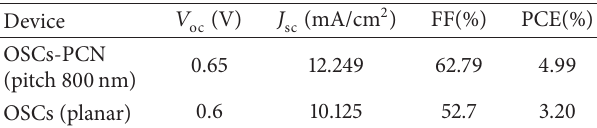
Figure 6: Current density versus voltage (J-V) characteristics of the OSCsonplanerandperiodicPCNstructures.TheJ-Vcharacteristics of devices: planar device (black circle), with a circular grating struc- ture (red square), and recorded under illumination at 100mW/cm 2 (AM 1.5). Table 1: Photovoltaic performances of organic solar cells for planar with periodic PCN structure under AM1.5 illumination (100mW/cm 2